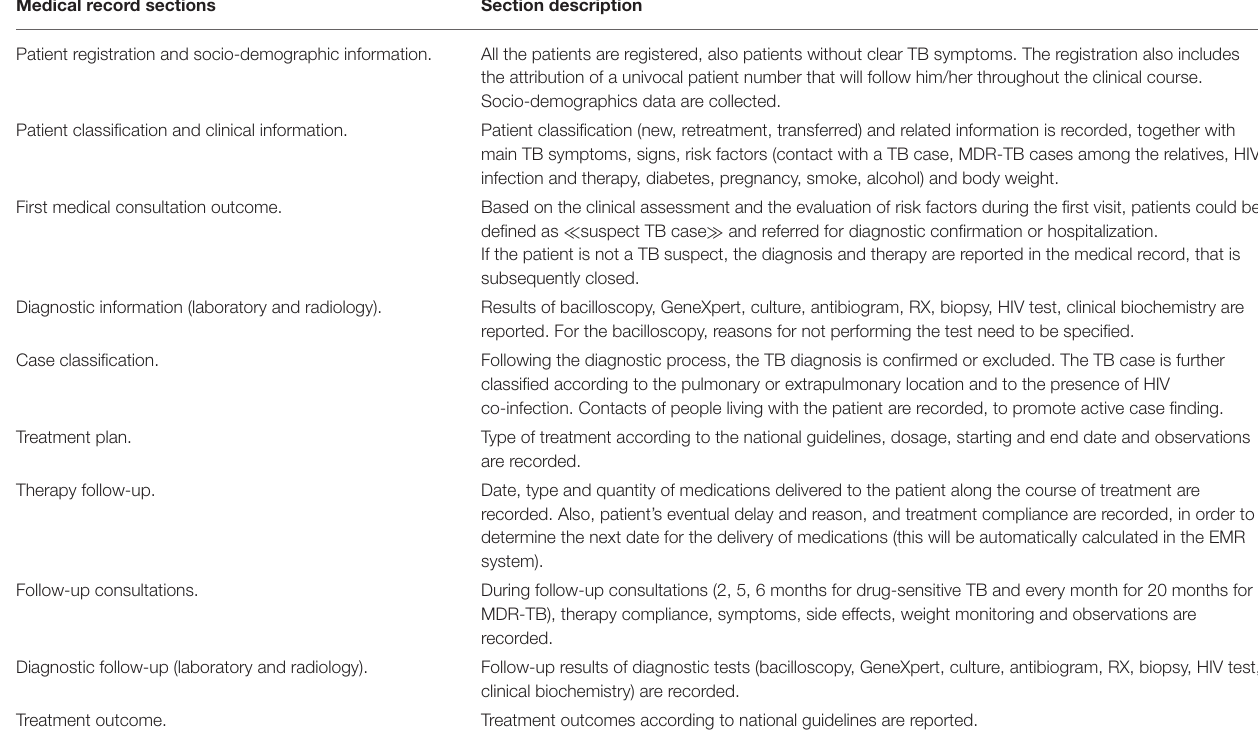
TABLE 3 | Enhanced TB medical record sections